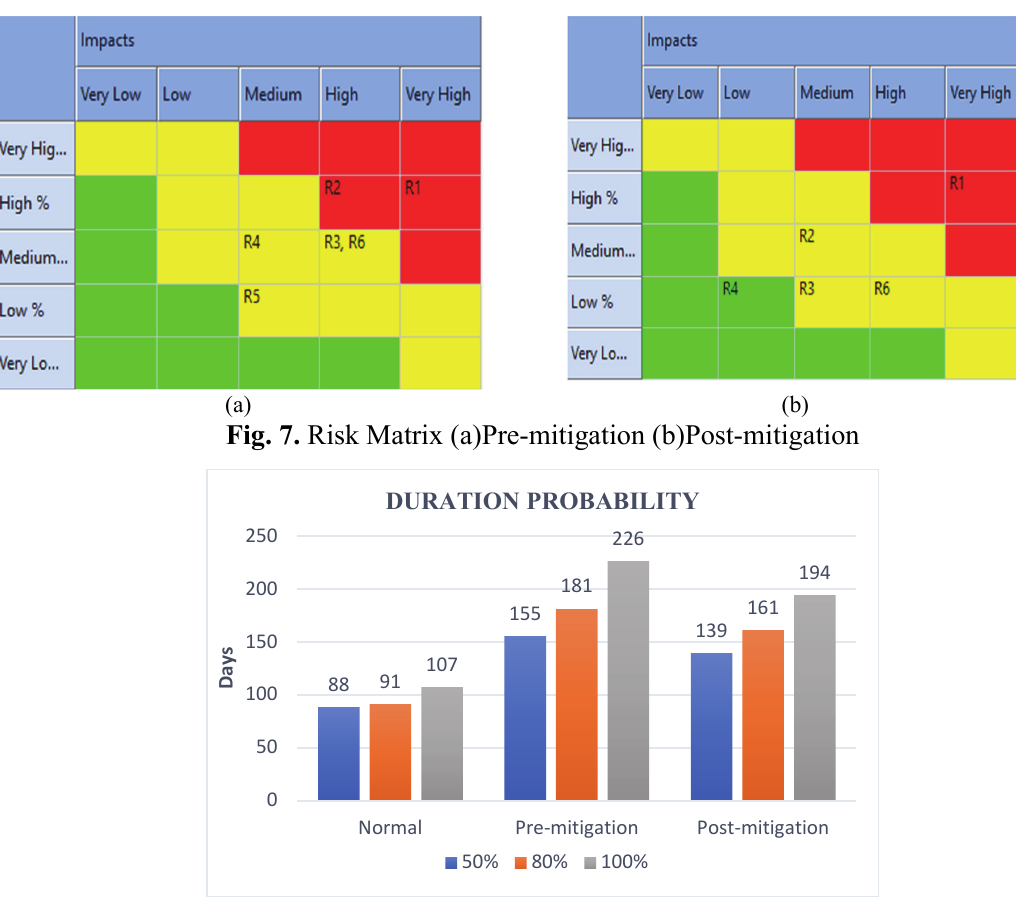
Fig. 8. Comparison of Normal, Pre-Mitigation and Post-Mitigation Duration